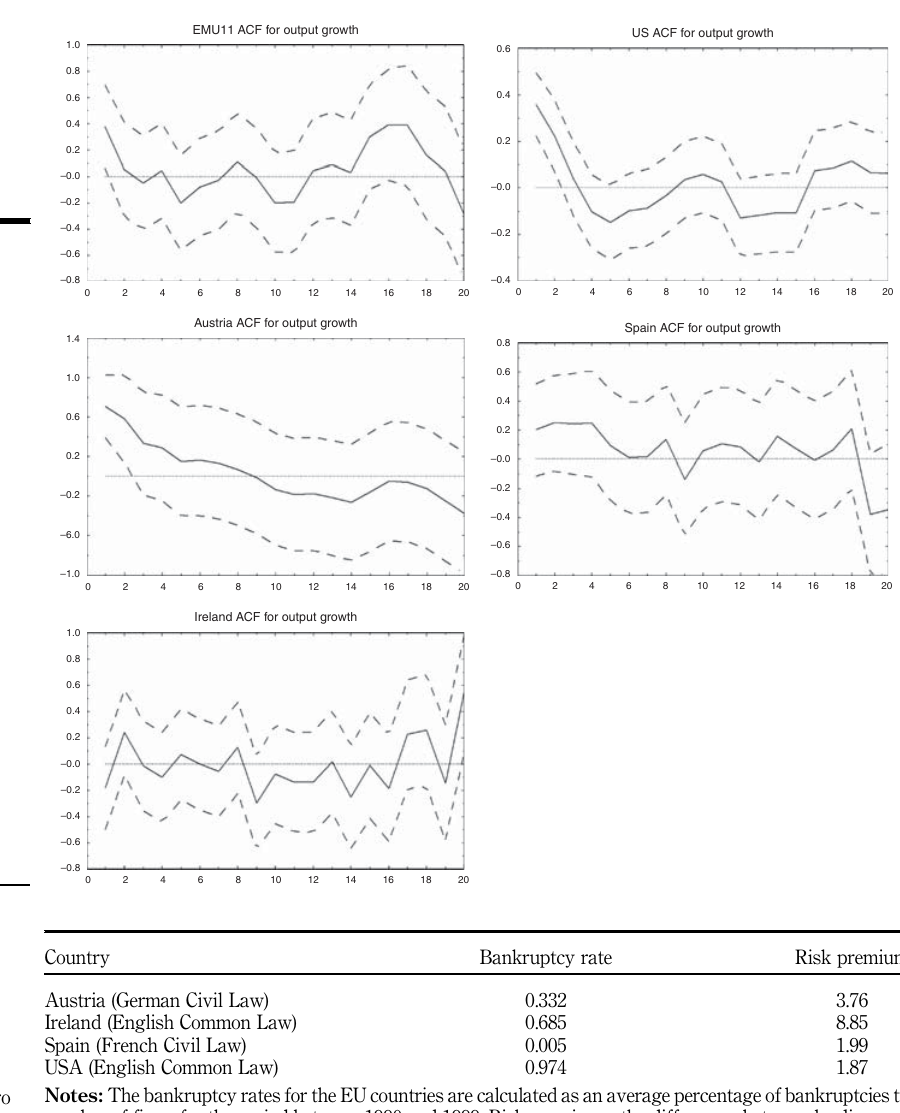
Table I. Financial sector information on Euro area countries and